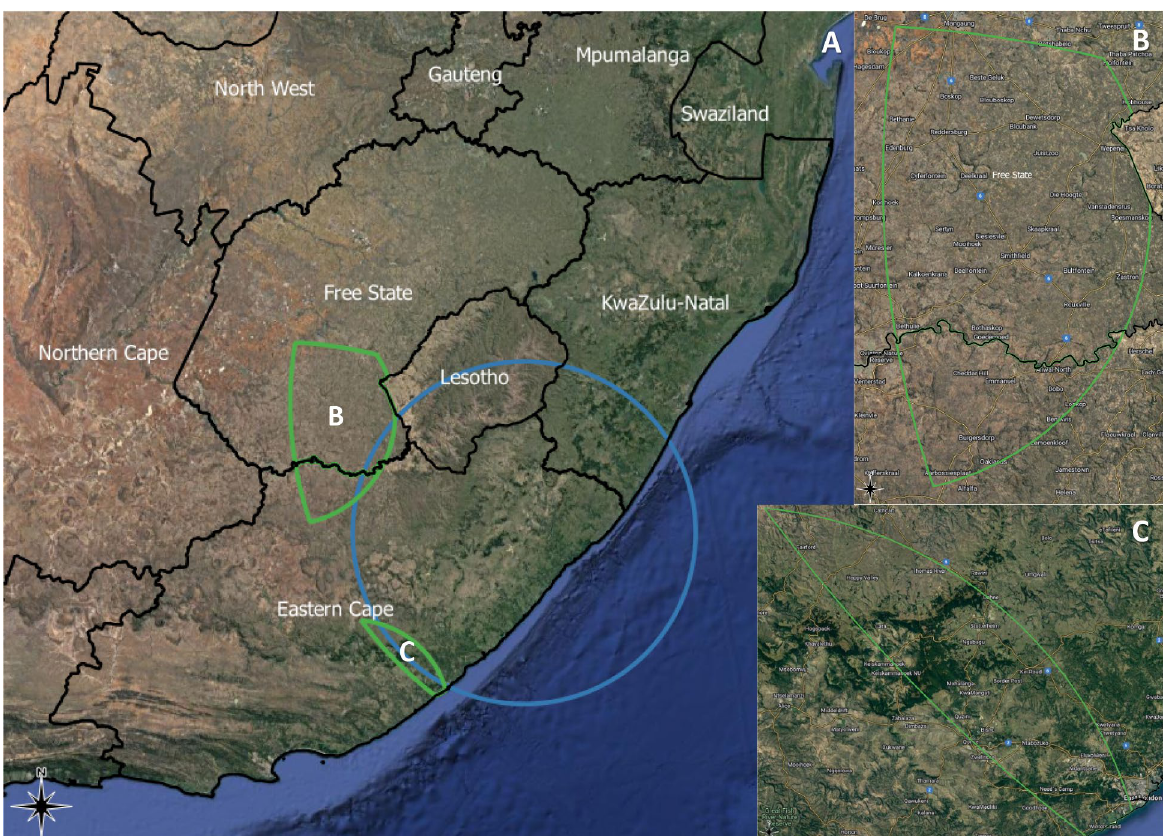
Figure 1. IPV Syndemics in South Africa. Green area indicates intersect of clusters in physical IPV, HIV, and harmful alcohol use where RERI > 0, AP > 0 and S > 1. Light blue indicates cluster of lowest wealth index quintile as a side note in image A. As noted previously, syndemic theory 12 synergistic clustering of population health conditions has socioeconomic adversities. Area B in image A is magnified in the image B. Area C in image A is magnified in the image C. The map was created using QGIS 3.10 (https:// www. qgis. org/ en/ site/ forus ers/ visua lchan gelog 310/ index.